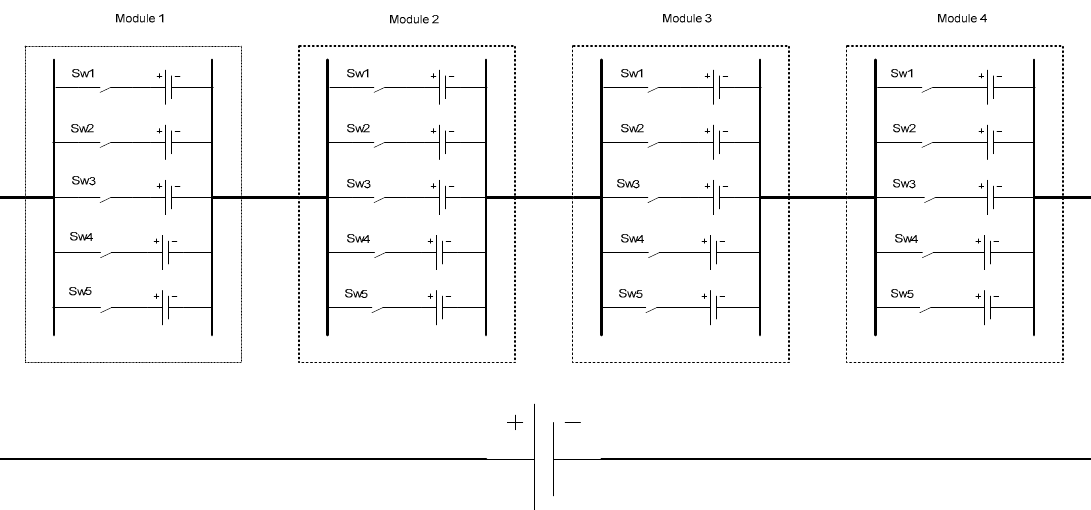
Figure 21. Modularization for utilization of optimal capacity.